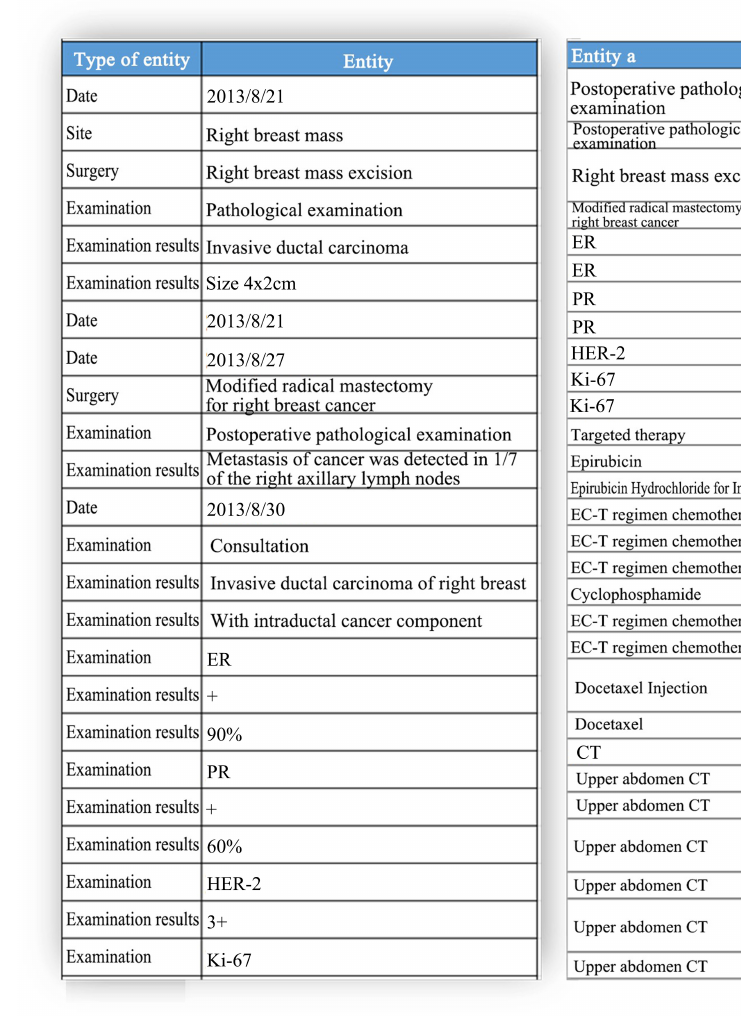
FIGURE 4 | Parsing results of some electronic medical records. ER, estrogen receptor; PR, progesterone receptor; HER2, human epidermal growth factor receptor-2; Ki-67, marker of proliferation